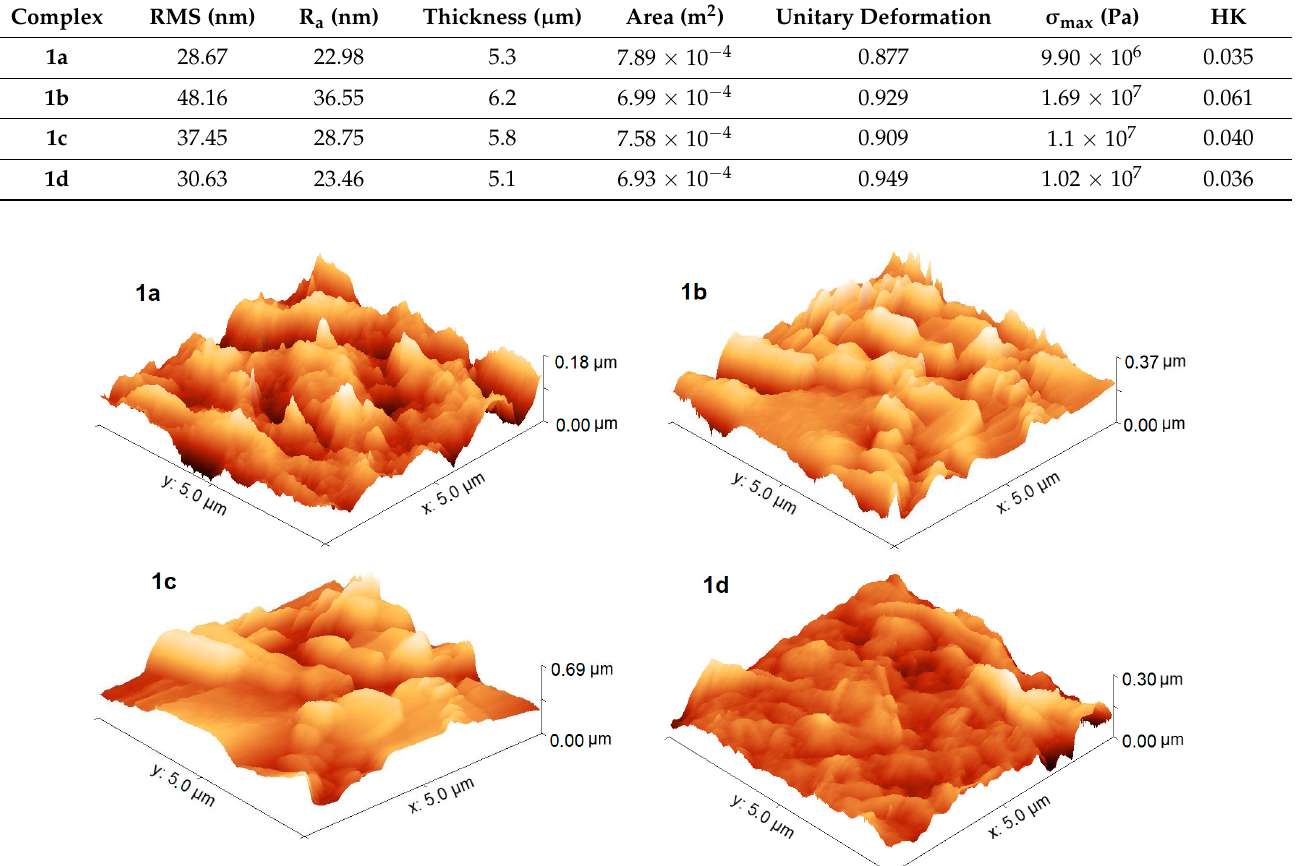
Table 4. Roughness, dimensions and mechanical parameters of hybrid films.